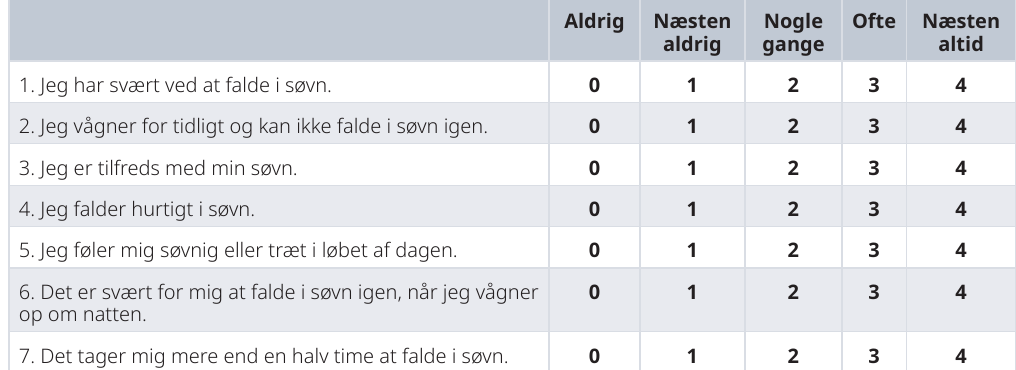
Markér det svar, som passer bedst.